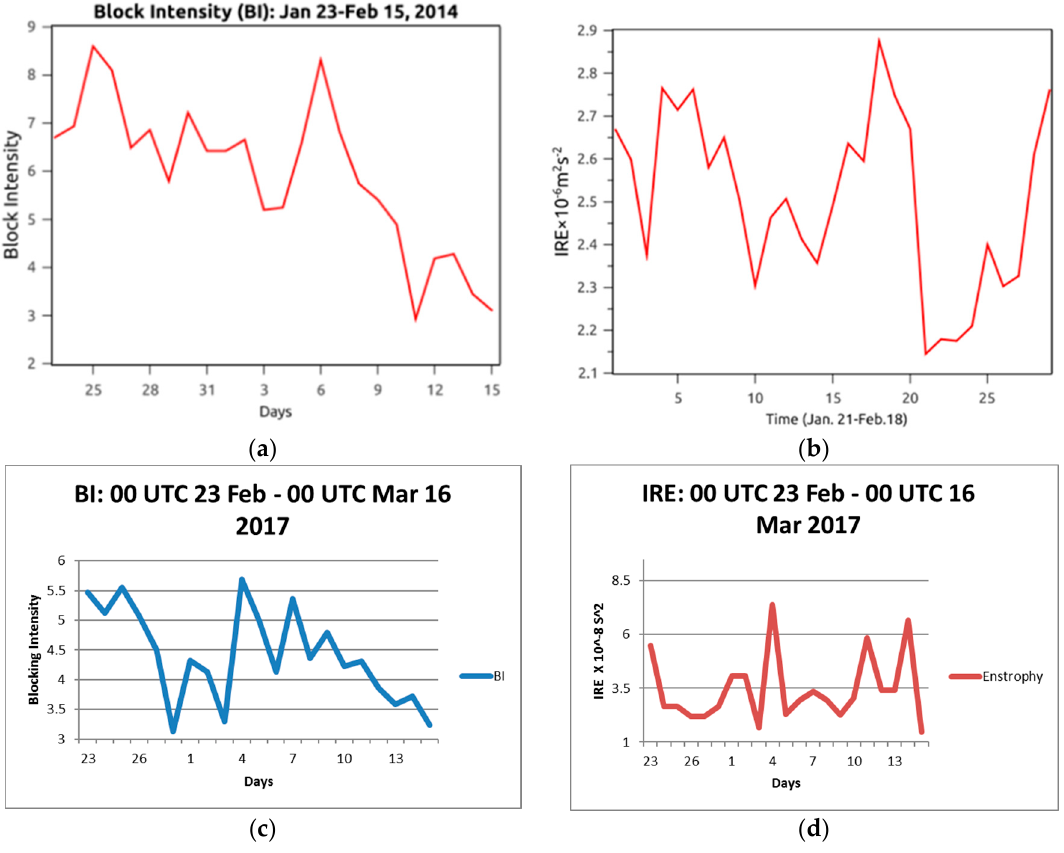
Figure 3. Adapted from [13], ( a , c ) the block intensity (BI) as defined by [24] (ordinate) for the event studied in winter 2014 versus date in January and February 2014 and February and March 2017, respectively, (abscissa) ( left ), ( b , d ) the (Integrated Regional Enstrophy (IRE) (s − 2 ) (ordinate) and days following the onset period in January and February 2014 and February and March 2017, respectively, (abscissa) ( right ).